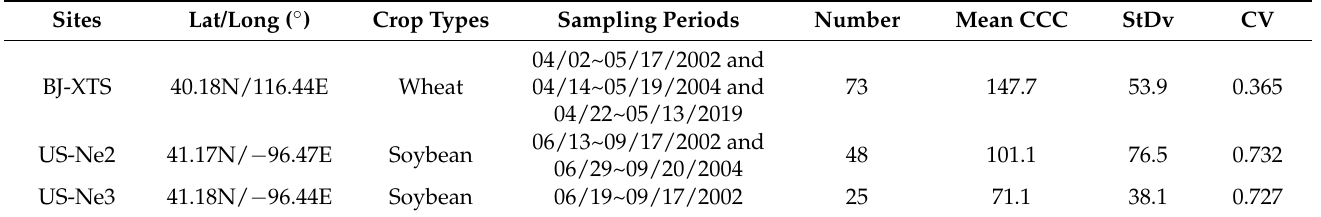
Table 1. Details of the study sites and statistics of the measured canopy chlorophyll content (CCC, µ g cm − 2 ) of wheat and